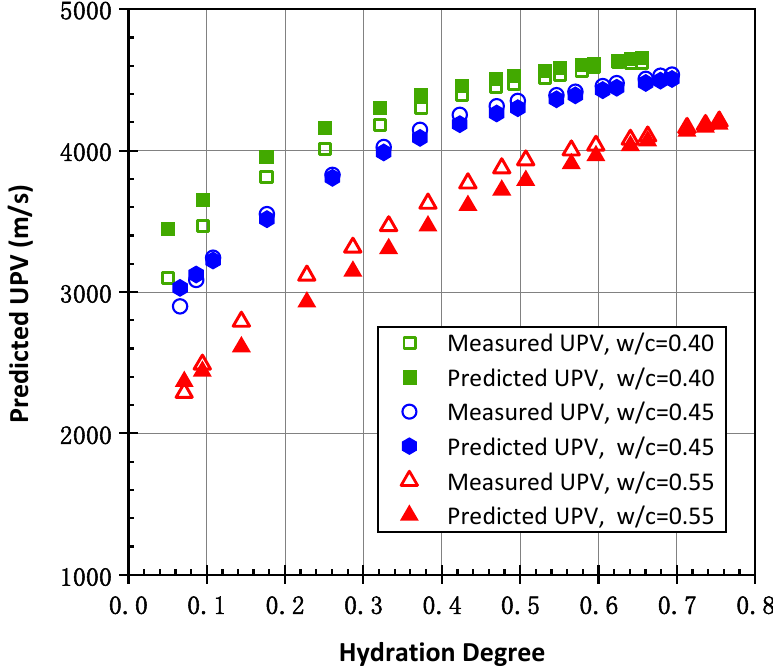
Figure 15. The comparison between predicted UPV and measured UPV of the hydration process with different w/c ratios.